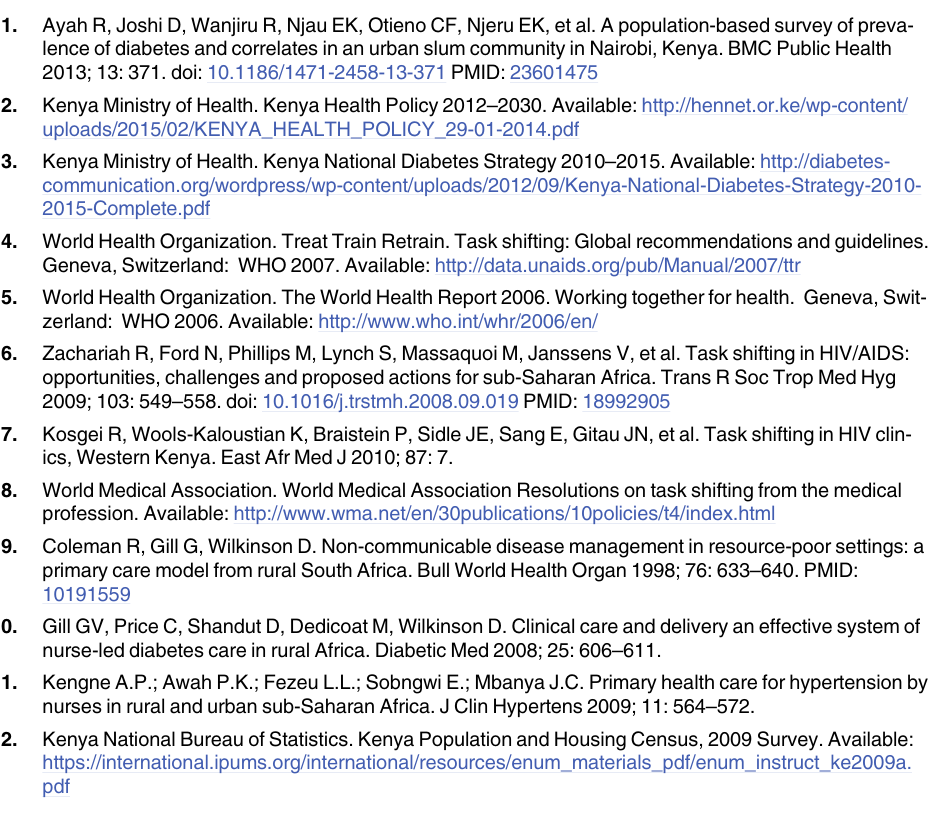
S2 Fig. NTS Data Collection Tool: a standardized paper format that was used for data col- lection by the task shifting